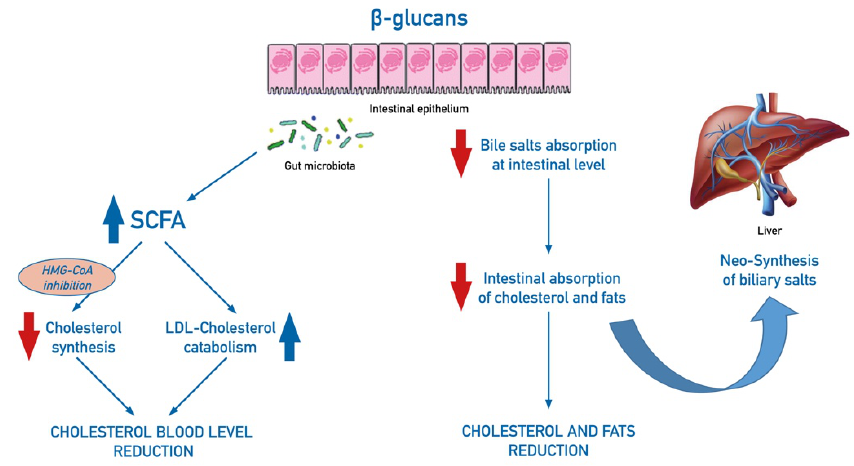
Figure 3. Schematic mechanisms of effect of dietary intake of β -glucans on cholesterol balance. β -glucans increase the production of short-chain fatty acids (SCFA) by intestinal microflora fermentation: SCFA inhibit cholesterol levels by acting on its synthesis, through inhibition of the hydroxymethylglutaryl-coenzyme A (HMG-CoA) reductase, and by increasing LDL-cholesterol catabolism. In addition, β -glucans, by forming a gel on the mucosal surface of the bowel, inhibit intestinal resorption of biliary salts, cholesterol, and fats and stimulate neo-synthesis of biliary salts in the liver.